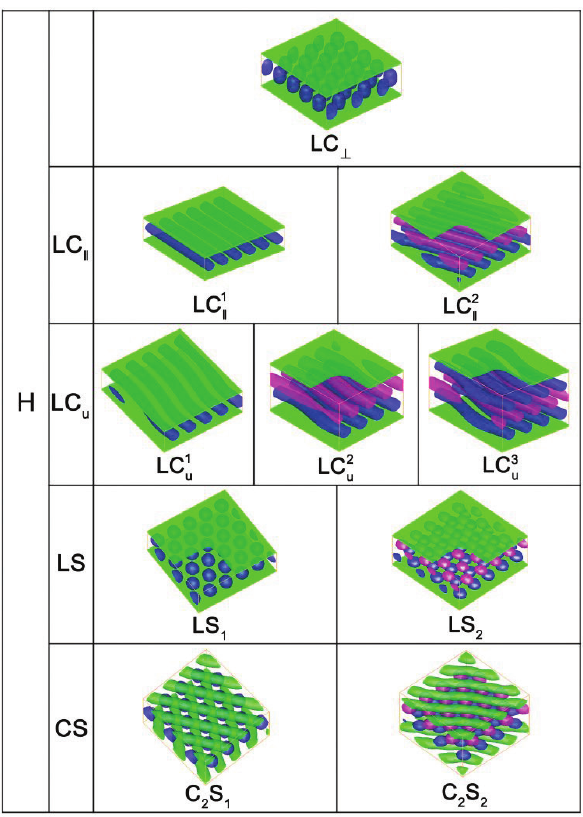
= 1/3). A small gap in A